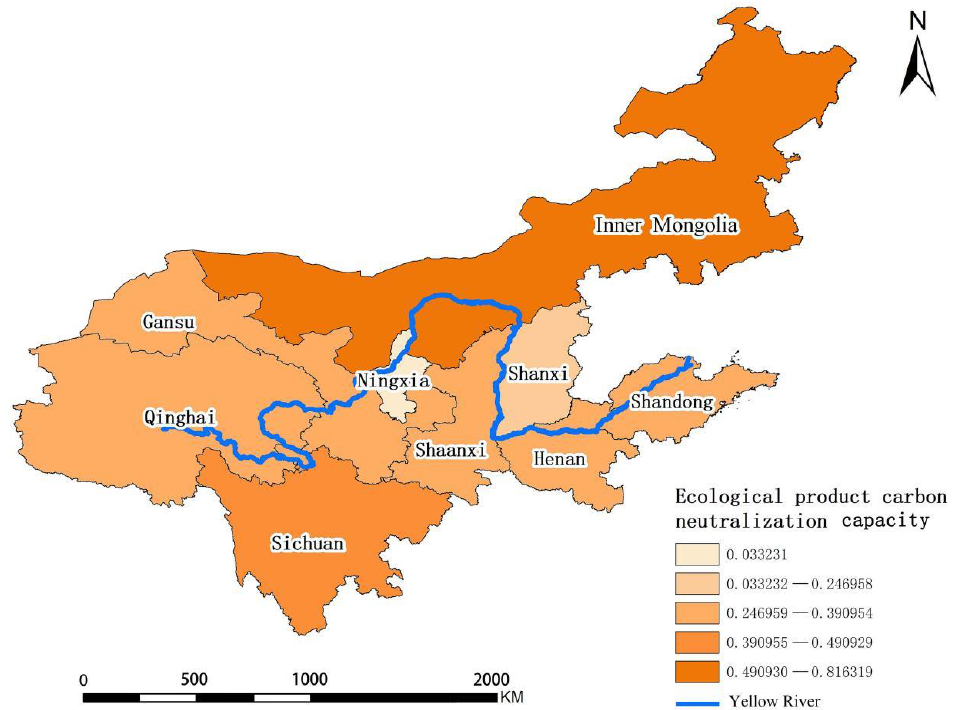
Figure 5. The carbon neutral capacity of ecological products